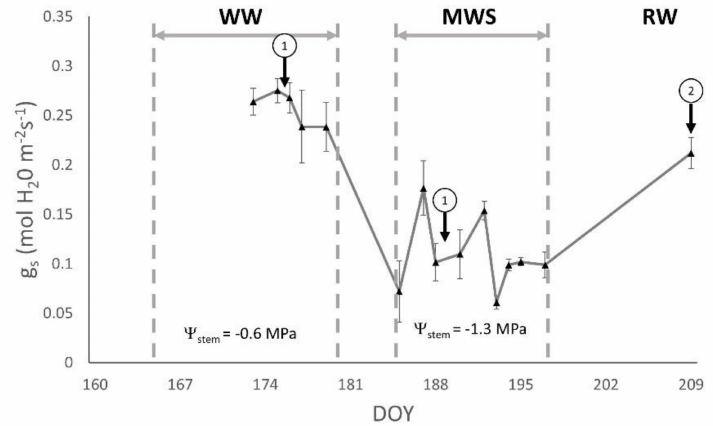
Figure 1. Variation of average stomatal conductance (g s ) along the measurement periods. The treatments are indicated by uppercase; WW: Wellwatered period, MWS: Moderate water stress period, RW: Rewatering period. The measurements were taken on the indicated day. Numbers indicate the measurements done at each moment, 1. Stem water potential and gas exchange measurements, 2. A/ C i and P-V